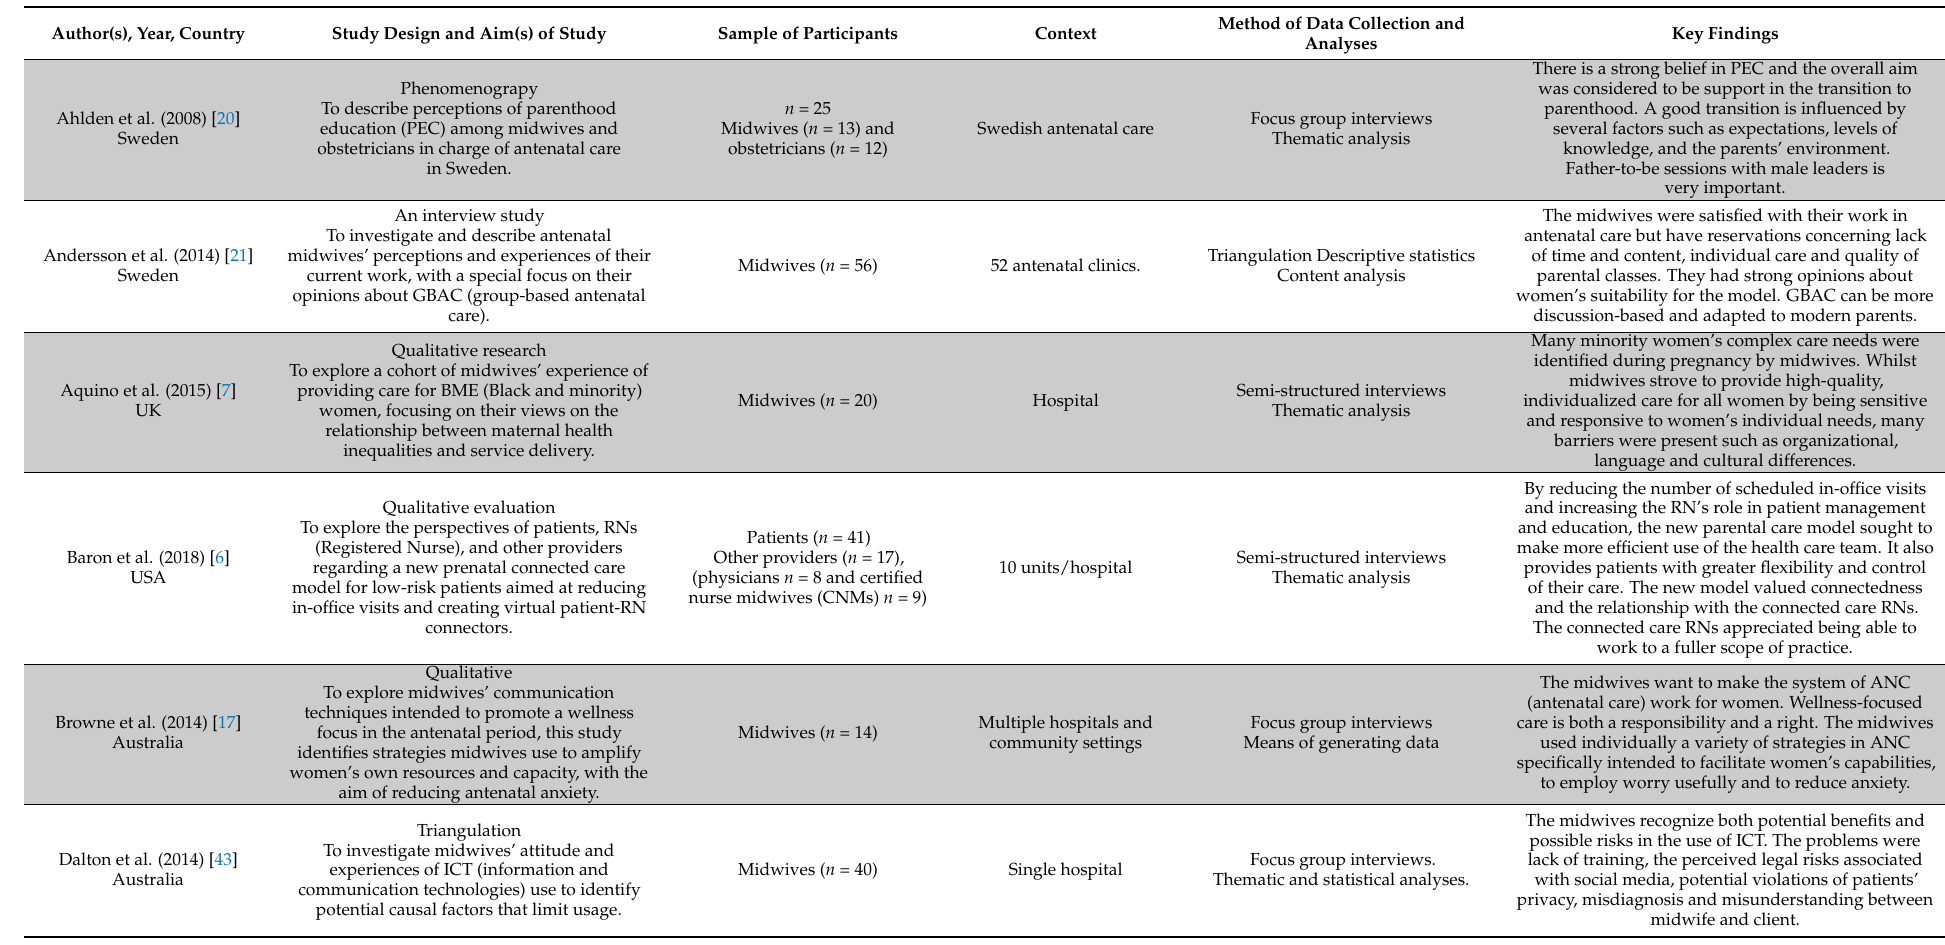
Table 4. Characteristics of selected studies ( n = 16) and key